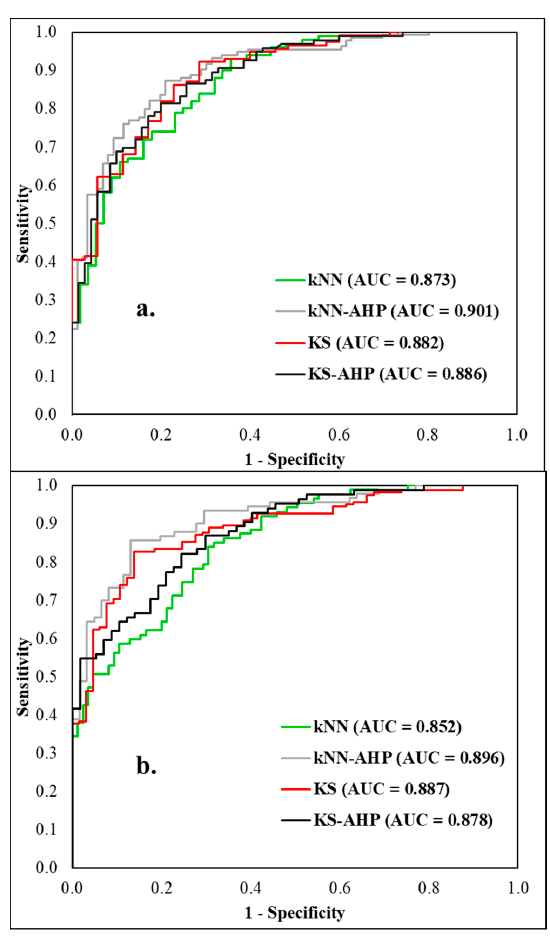
Figure 13. Receiver Operating Characteristics (ROC) curves and Area Under Curve (AUC) values based on training dataset ( a ) success rate; and validating dataset ( b ) prediction rate. * kNN – k-Nearest Neighbor; kNN-AHP – k-Nearest Neighbor – Analytical Hierarchy Process; KS – K Star; KS-AHP – K Star – Analytical Hierarchy Process.